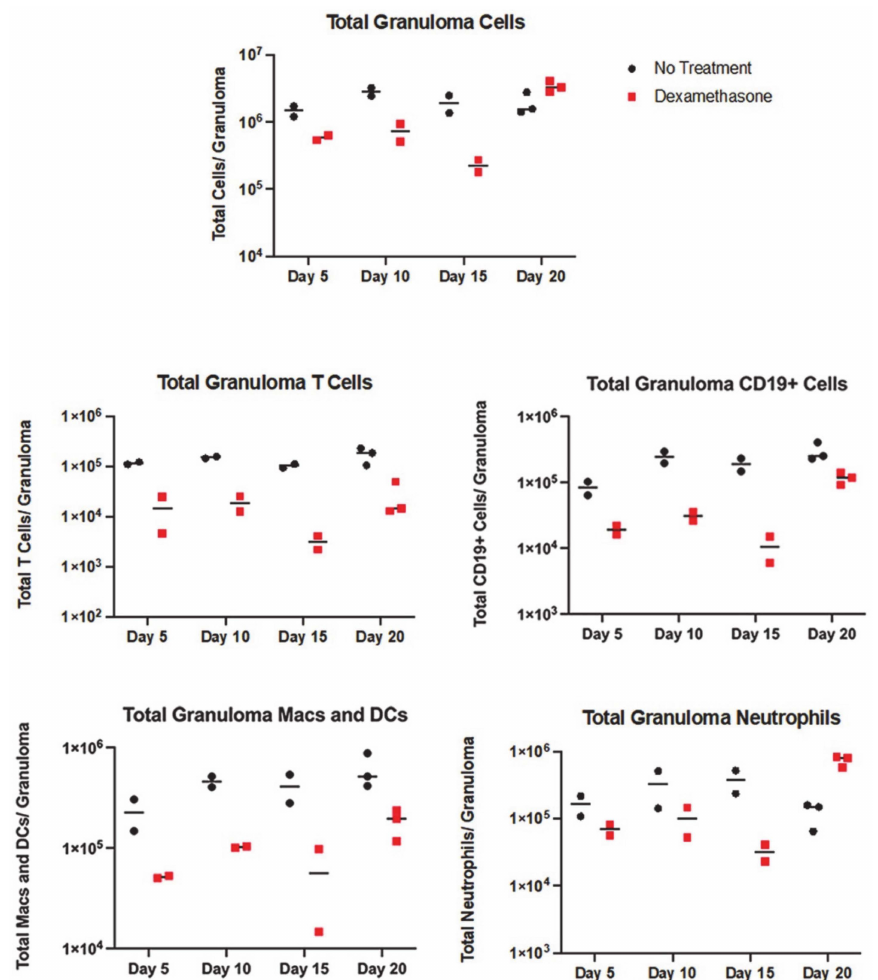
Figure 4. Flow cytometry counts of immune cells in treated and untreated mice. Total immune cells in the granulomas reduce between day 5 and 15 after starting DXM. There is a rebound on day 20. T-cell populations remain depressed at all time points, along with the modest reduction in macrophage/DC lines, but CD19 + B-lineage cells and neutrophils show an increase on day 20. Population subsets are shown in Supplementary Figures S1 and